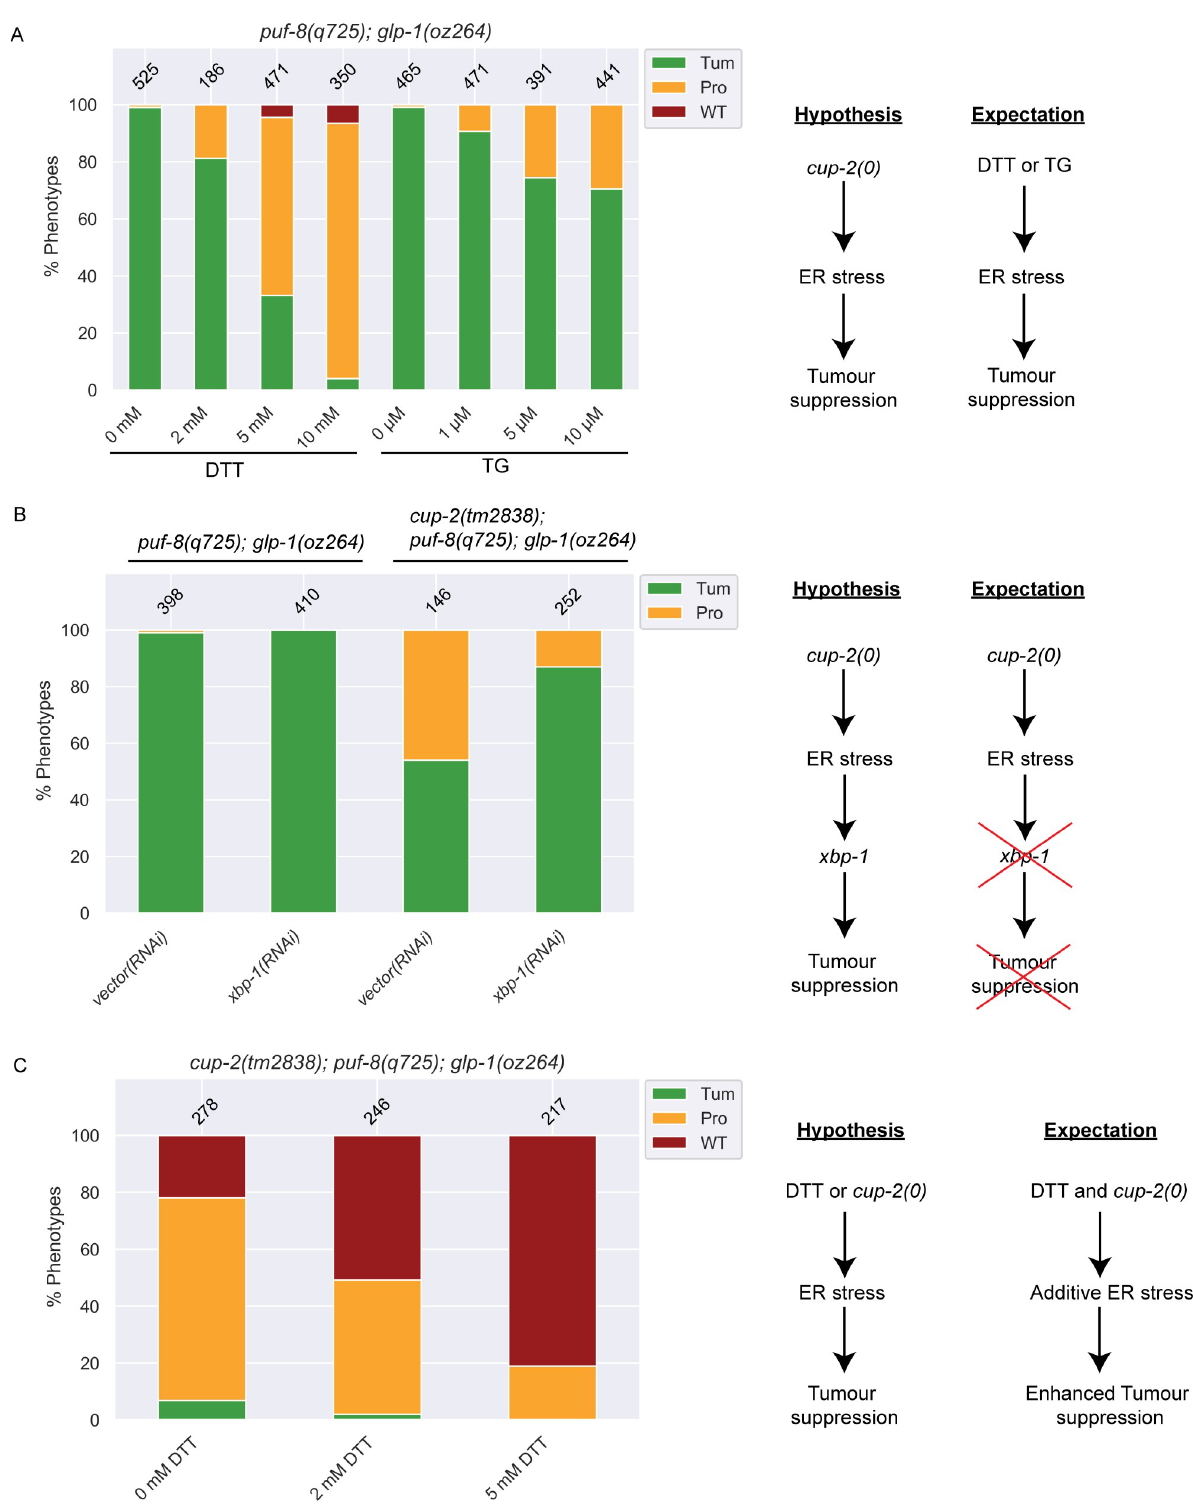
Fig 7. Chemical induction of ER stress also suppresses Notch-dependent tumours and suppression of tumours by loss of cup-2 activity requires xbp-1 , a key player in the Unfolded Protein Response. A. Quantification of phenotypic analysis of the effect of increasing doses of DTT and Thapsigargin (TG) on suppression of puf-8(q725); glp-1(oz264) tumours. We hypothesize that if ER stress induced by abrogating cup-2 activity is responsible for the suppression of the tumour, then inducing ER stress by chemical means should also produce a similar effect. Phenotypes were